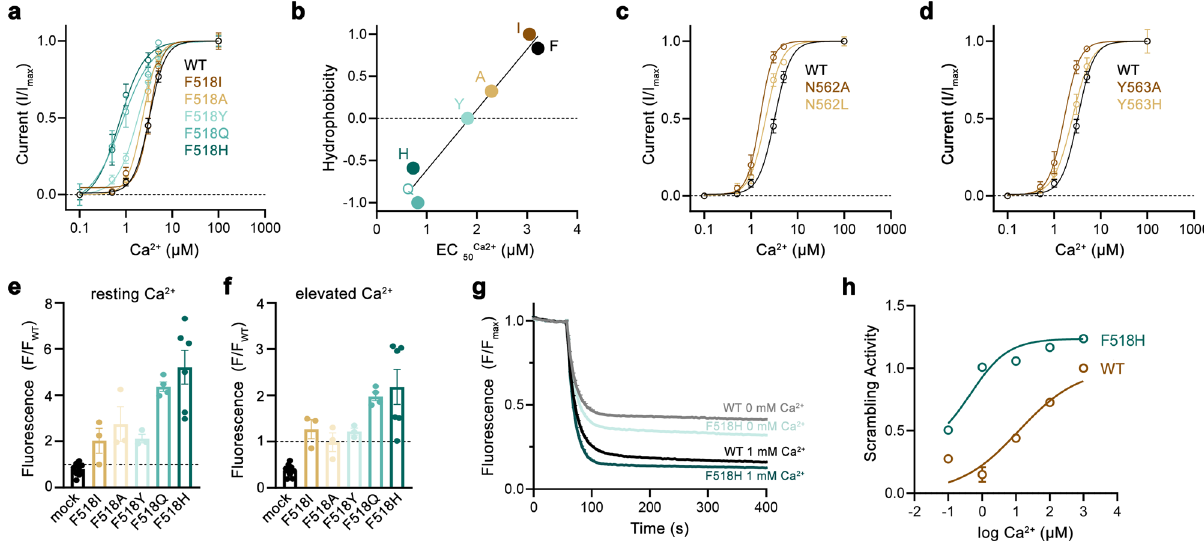
Fig. 2 | Characterization of activating mutants. a Ca 2+ -concentration-response relationshipsofmutantsofPhe518measuredininside-outpatches. b EC 50 valuesof Ca 2+ plotted against the normalized hydrophobicity (Eisenbergand Weiss Scale) of therespectivePhe518mutations.Lineshowsa fi ttothedata. c Ca 2+ -concentration- responserelationshipsofmutantsofAsn562and d Tyr563measuredininside-out patches. a , c , d Data show averages of multiple experiments derived from inde- pendentcells(WT n =10,F518H n =5,F518Q n =4,F518Y n =5-6,F518A n =5-9,F518I n =7,N562A, n =5,N562L n =4, Y563A n =5, Y563H n =3 – 6),errorsare s.e.m., lines show fi t to a Hill equation. e , f Lipid transport of Phe 518 mutants quanti fi ed in a cellularscramblingassay. e InitialvaluesrecordedatrestingCa 2+ concentrationand f levels measured 600s after application of ionomycin, which increases